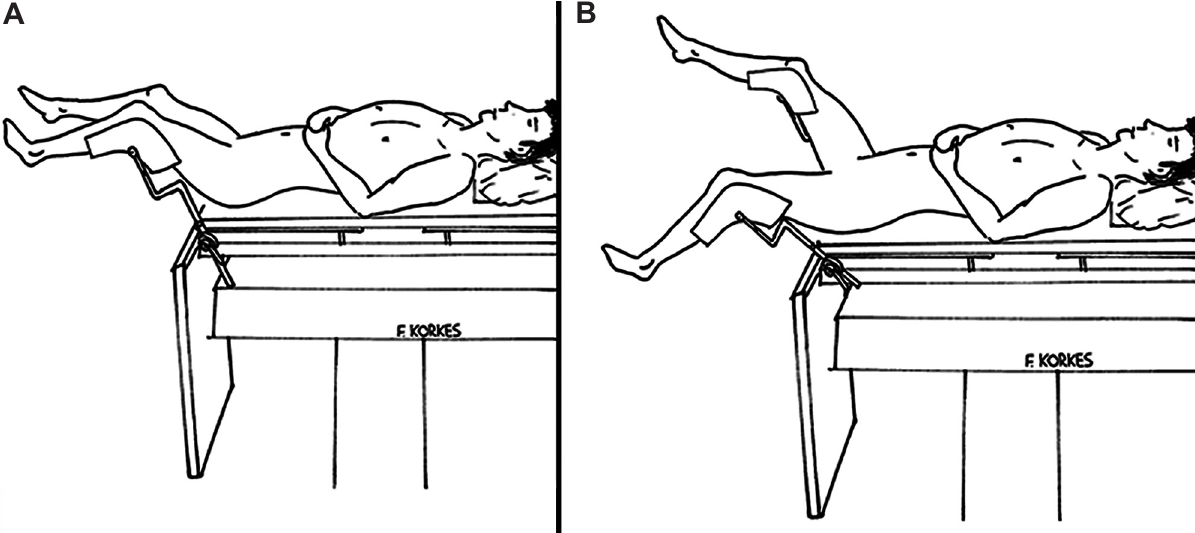
Figure 1 – Patient position during left ureteroscopy: A) Dorsal lithotomy position. B) Dorsal lithotomy with extended